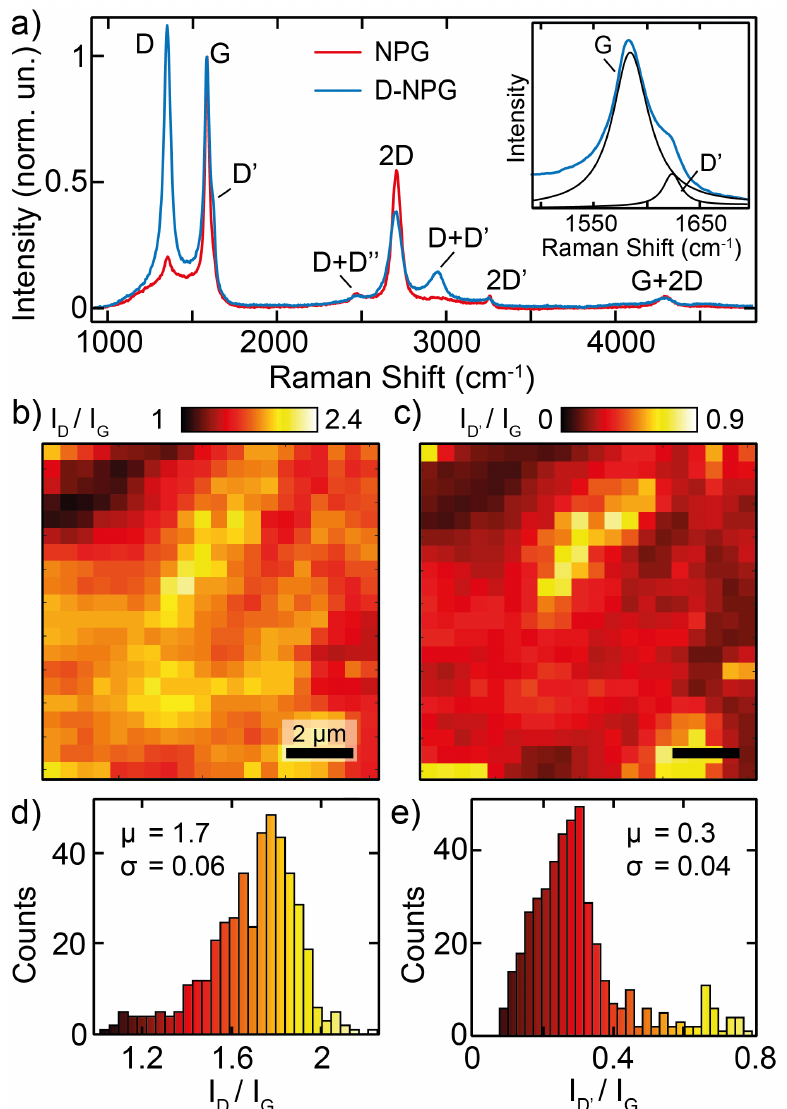
Figure 1. ( a ) Raman spectra taken on the pristine (red line) and deuterated NPG (blue line) sample, acquired with a λ = 532.2 nm excitation laser; in the inset we see the zoomed region of G and D (cid:48) bands with Lorentzian fitting. ( b , c ) Deuterated-NPG: spatial mappings of the I D /I G and I D (cid:48) /I G intensity ratios, respectively, over an area of 10 µ m × 10 µ m with a 500-nm step. ( d , e ) Deuterated- NPG: occurrence distribution of the I D /I G and I D (cid:48) /I G intensity ratios, respectively ( µ , mean value; σ , standard